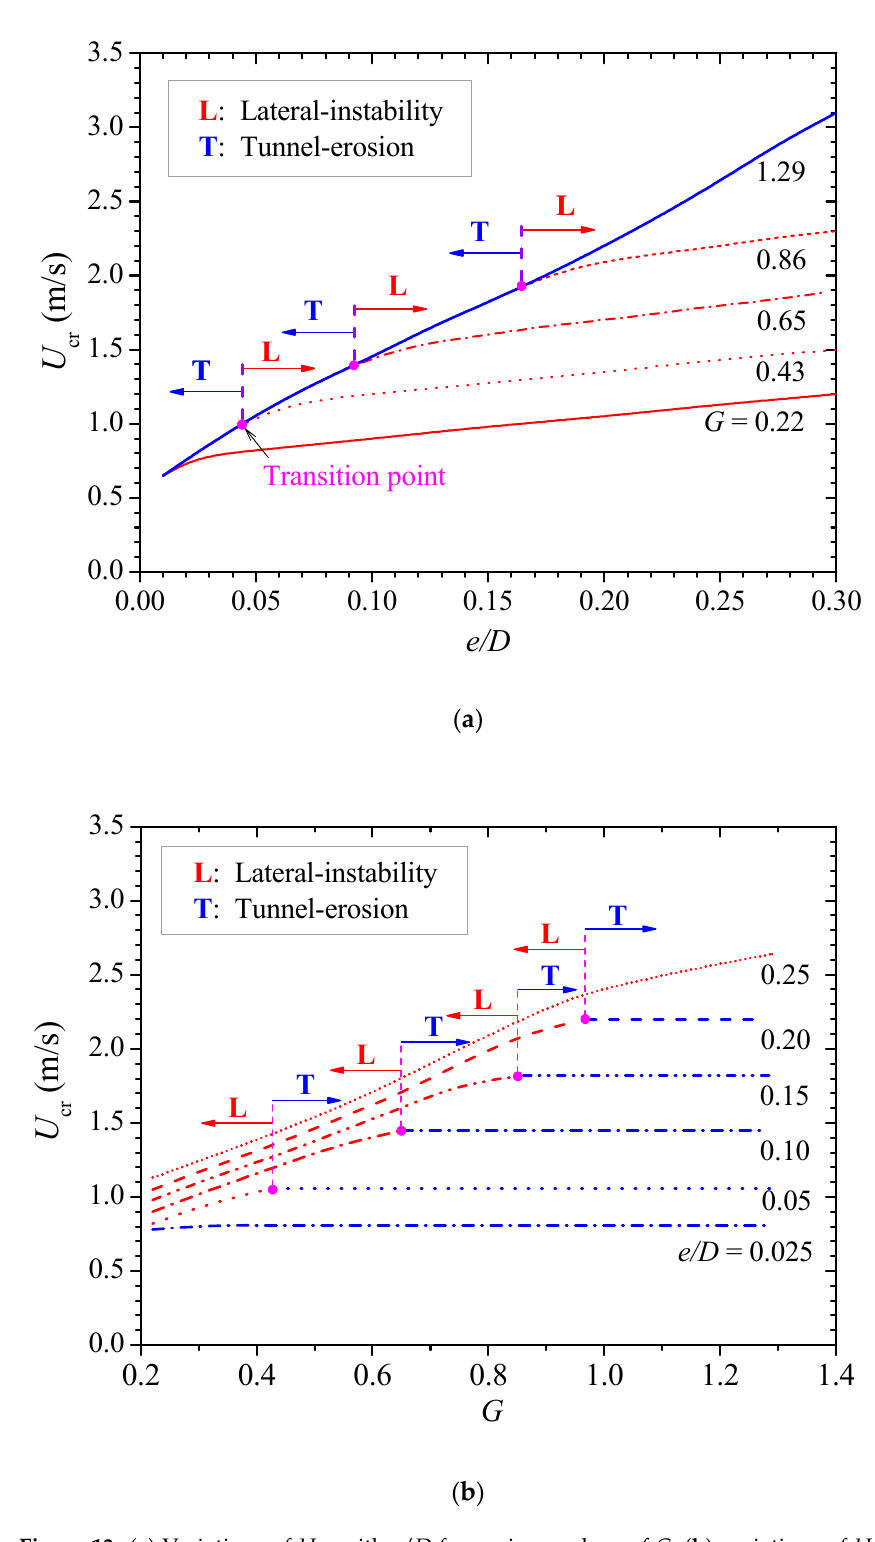
Figure 13. ( a ) Variations of U cr with e / D for various values of G ; ( b ) variations of U cr with G for various values of e / D .